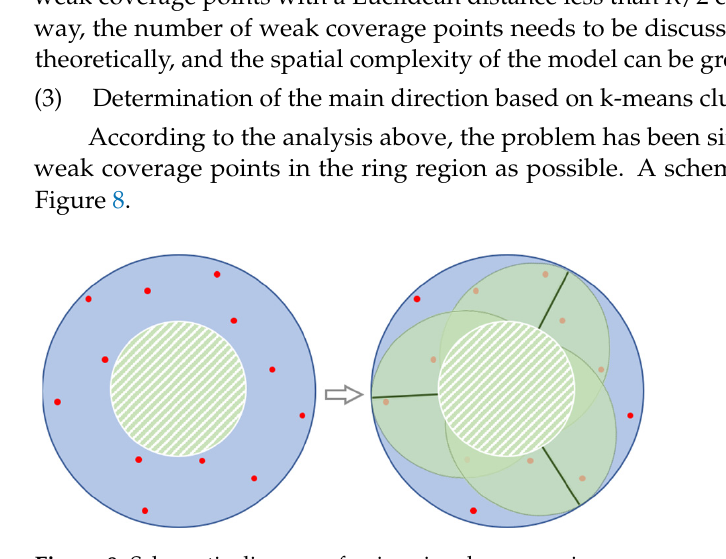
Figure 8. Schematic diagram of a ring signal cover region.